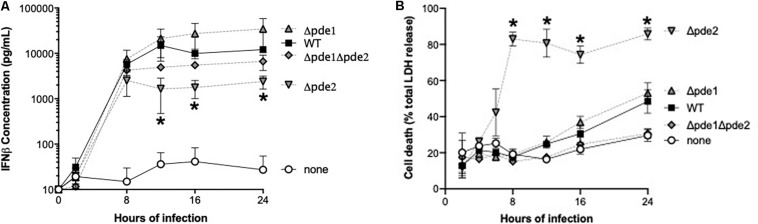
Outcome of infection is dictated by pneumococcal phosphodiesterase 2. (A) Time-course of IFNβ protein accumulation in the supernatant was measured in mouse macrophage-like RAW264.7 cell cultures infected with the indicated bacteria. Mouse IFNβ concentration was measured using ELISA (N = 3 experiments). (B) Time-course of cell death was measured in mouse macrophage-like RAW264.7 cell cultures infected with the indicated bacteria. Concentration of the cytosolic enzyme lactate dehydrogenase (LDH) was measured using a commercially available cytotoxicity assay kit, and expressed relative to concentrations measured after cells were completely lysed by detergent (N = 3 experiments). Throughout panels, asterisk (*) indicates P < 0.05 compared to WT.